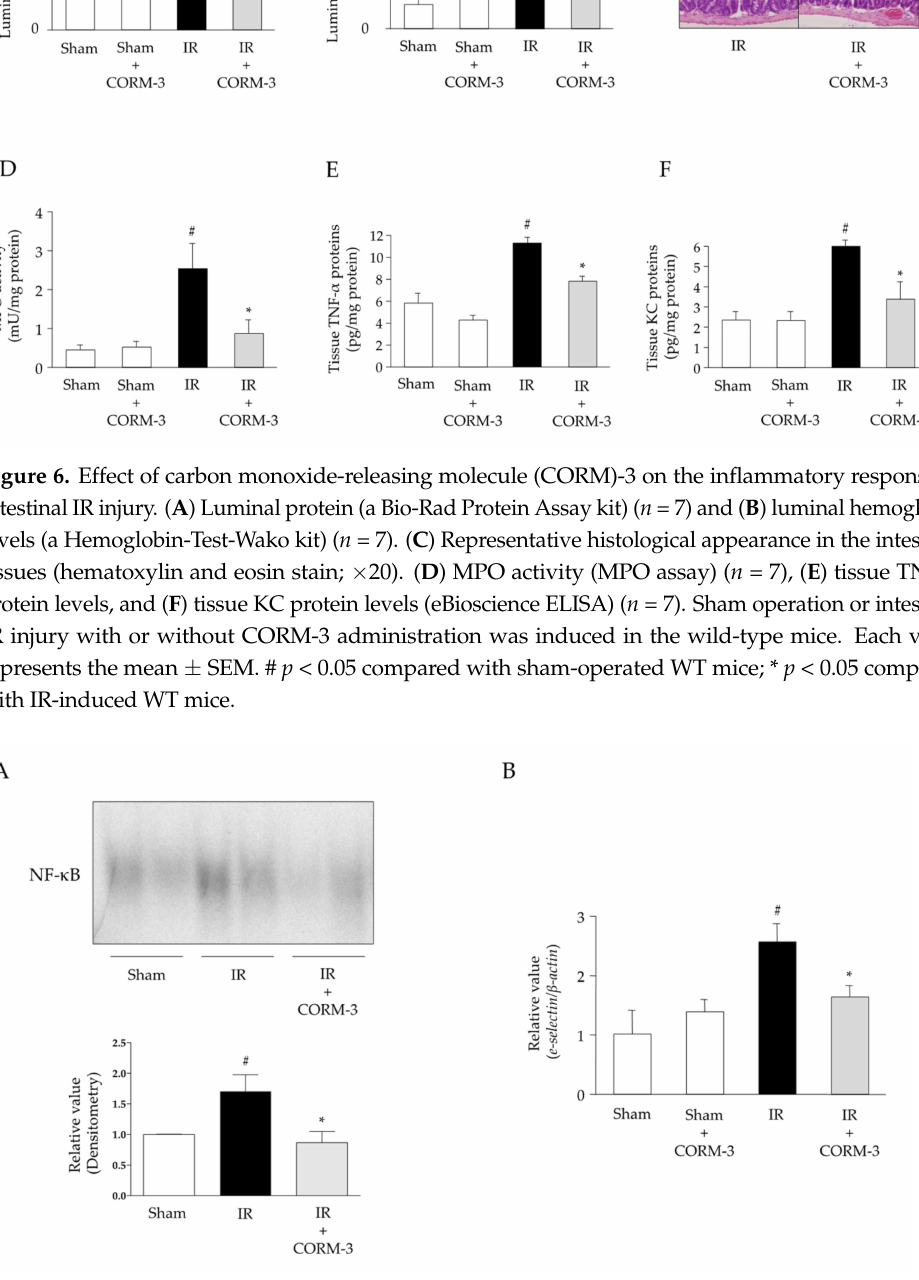
Figure 7. Effects of CORM-3 on nuclear factor (NF)- κ B activation and expression levels of downstream adhesion molecule E-selectin in intestinal IR injury. ( A ) A representative electrophoretic mobility shift assay (EMSA) image and densitometry analysis ( n = 4–6). ( B ) e-selectin mRNA expression (real-time PCR) ( n = 7). Sham operation or intestinal IR injury with or without CORM-3 administration was induced in the wild-type mice. Each value represents the mean ± SEM. # p < 0.05 compared with sham-operated WT mice; * p < 0.05 compared with IR-induced WT